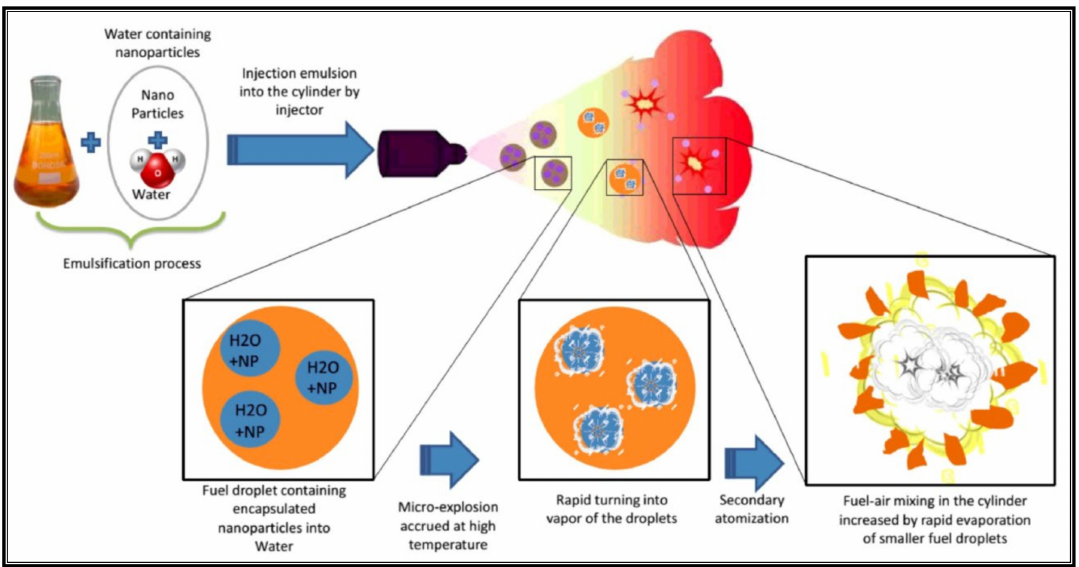
Figure 8. Microexplosion phenomenon [45] (Adapted with permission from Elsevier B.V., Progress in Energy and Combustion Science., License Number: